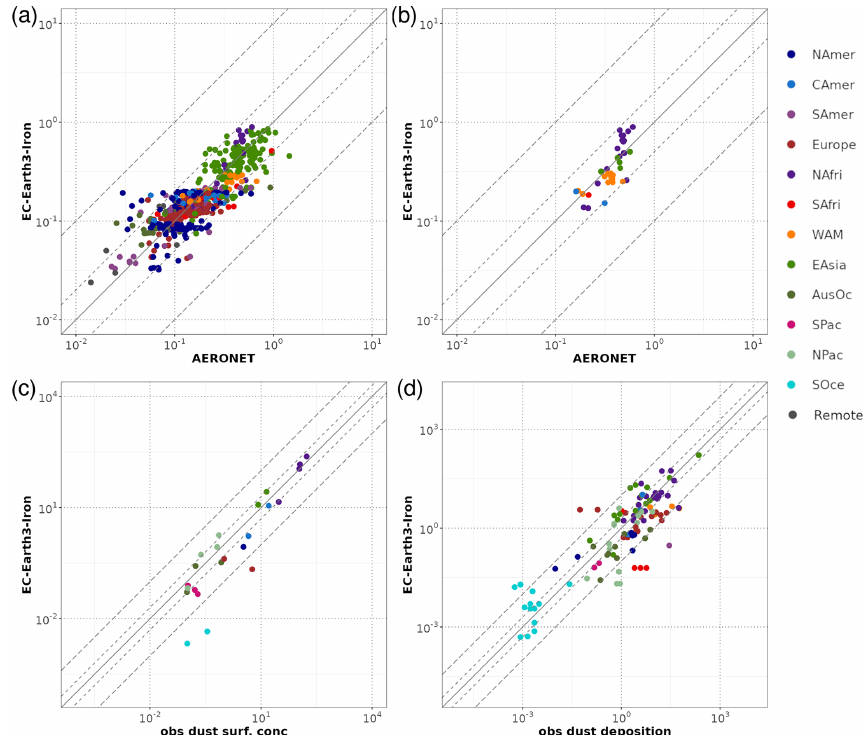
Figure 4. Comparison of (a) the modeled annual mean AOD at 550nm against AERONET retrievals for all available stations covering the 2000–2014 period, (b) the same but for selected dusty AERONET sites, (c) the same but for modeled annual mean dust surface concentration for 2000–2014 compared to climatological mean values from RSMAS sites and AMMA campaign, and (d) the same but for modeled annual dust deposition flux averaged for the period 2000–2014 against observations compiled in Albani et al. (2014) from several